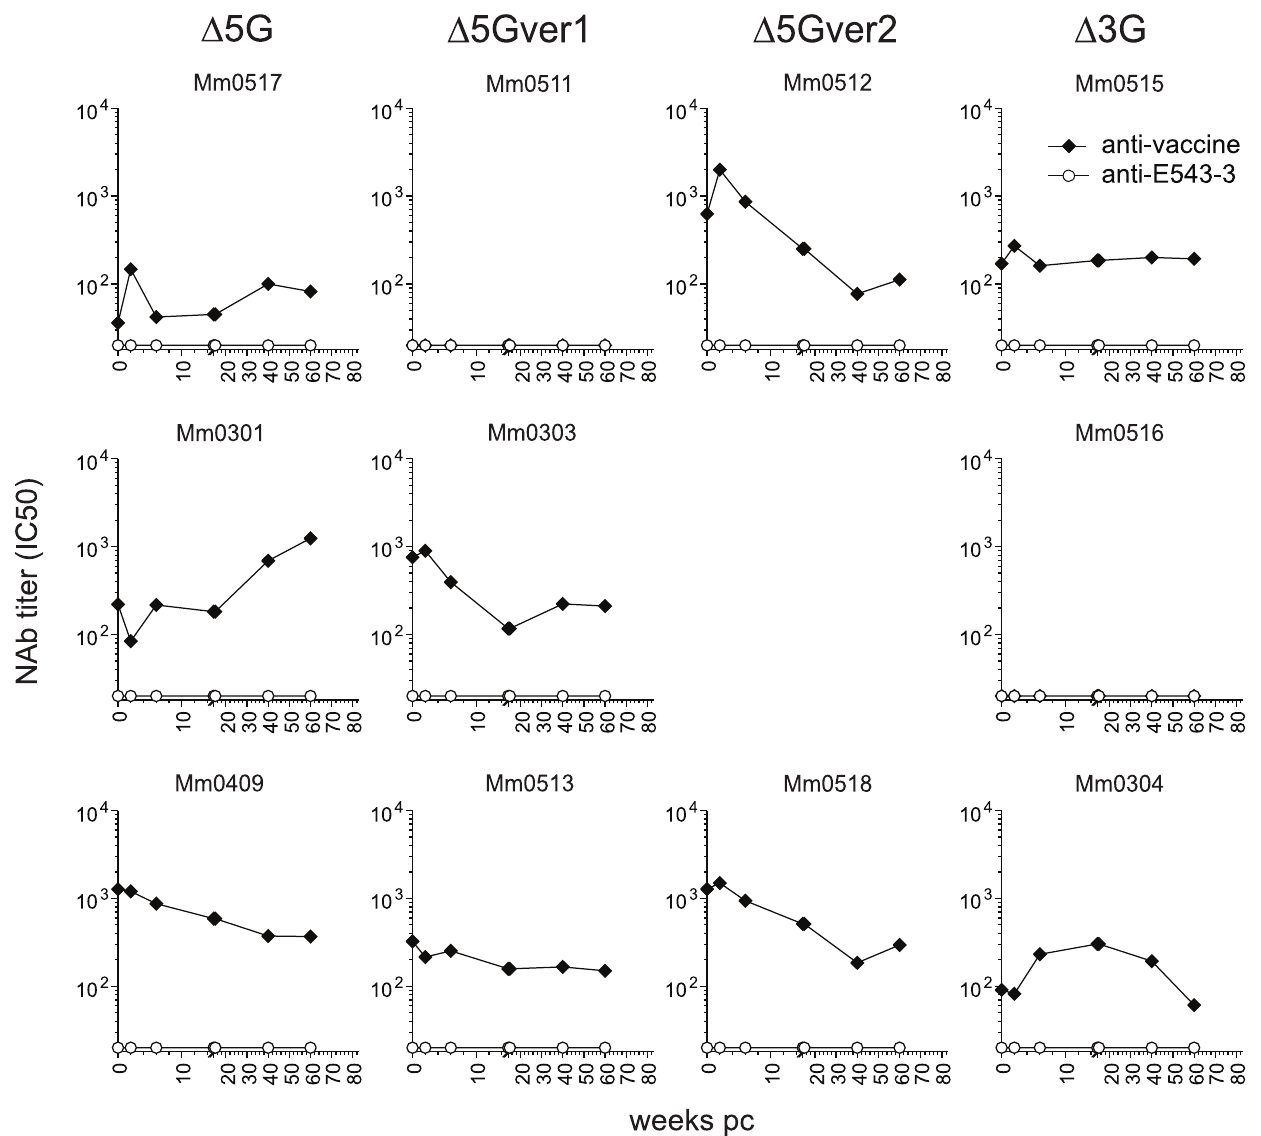
Figure 5. Neutralizing antibodies (NAb) response in the vaccine recipients. NAb responses against vaccine viruses (closed squares) and challenge virus (open circles) were measured in CEMx174/SIVLTR-SEAP system. NAb titers were indicated as the reciprocal of the dilutions of the plasma from the vaccinees yielding 50% inhibition (IC 50 ).